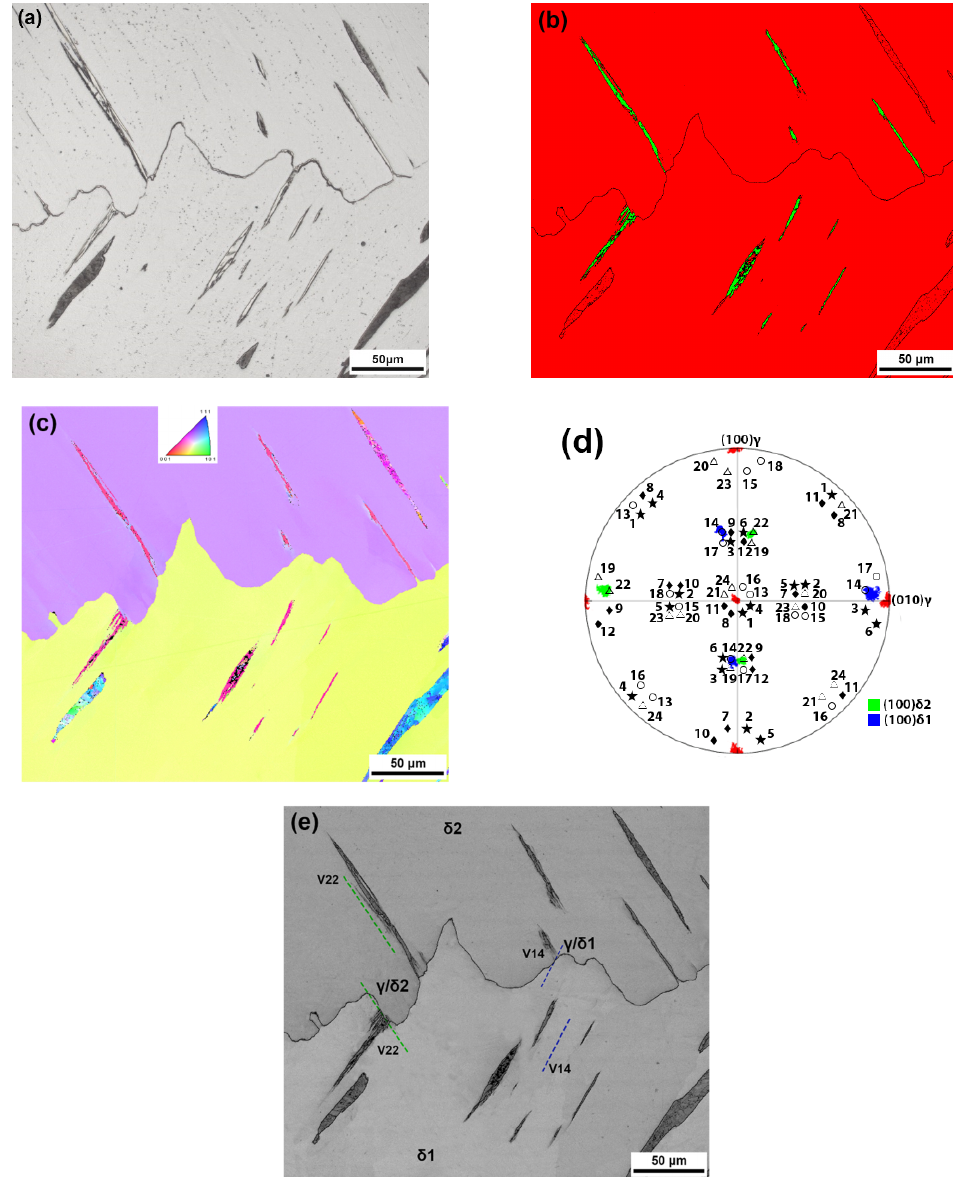
Figure 11. Nucleation of WA on the high-angle δ -ferrite boundary with the occurrence of a zig-zag boundary and growth of WA laths into both grains; ( a ) precipitation in δ -ferrite, decomposition of WA to pearlite and plate martensite + retained austenite. LM; ( b ) phase map: ferrite = red, retained austenite = green; ( c ) IPF orientation map for ND; ( d ) combined stereographic projection (001) γ + <001> δ for K-S OR variants with inserted EBSD data for both δ -ferrite grains (blue and green) and austenite (red); ( e ) IQ map with marked traces of the γ / δ 1 and γ / δ 2 interfaces along the δ-ferrite grain boundary and directions of the WA growth in ferritic grains (V22: green lines, V14: blue lines).